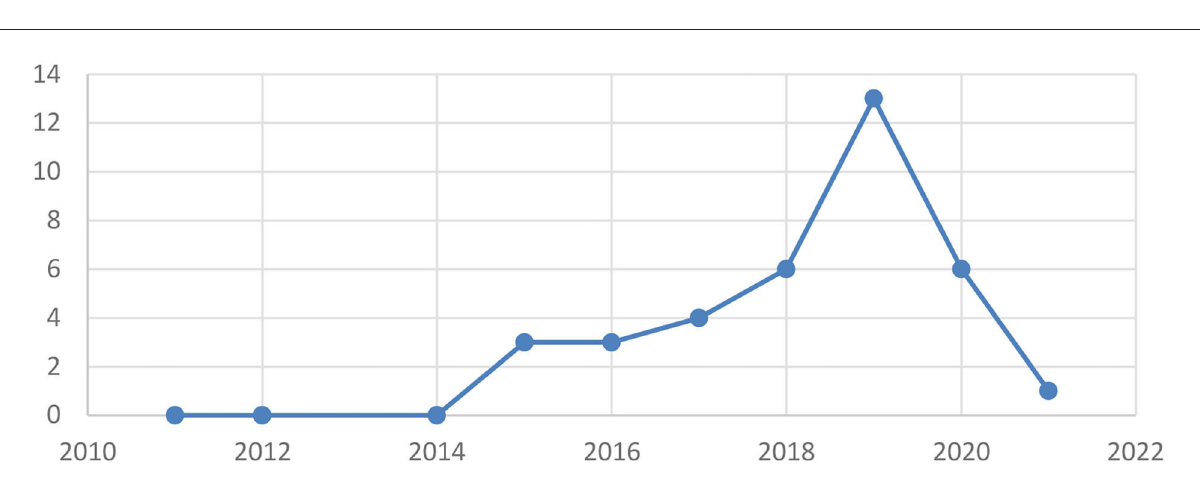
FIGURE4 Evolution over years of the controls used in studies from 2010 to